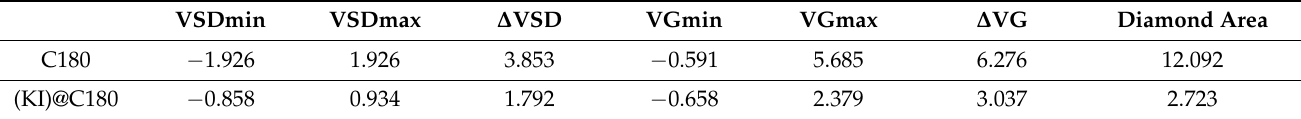
Table 2. The main parameters of the central Coulomb diamond according to stability